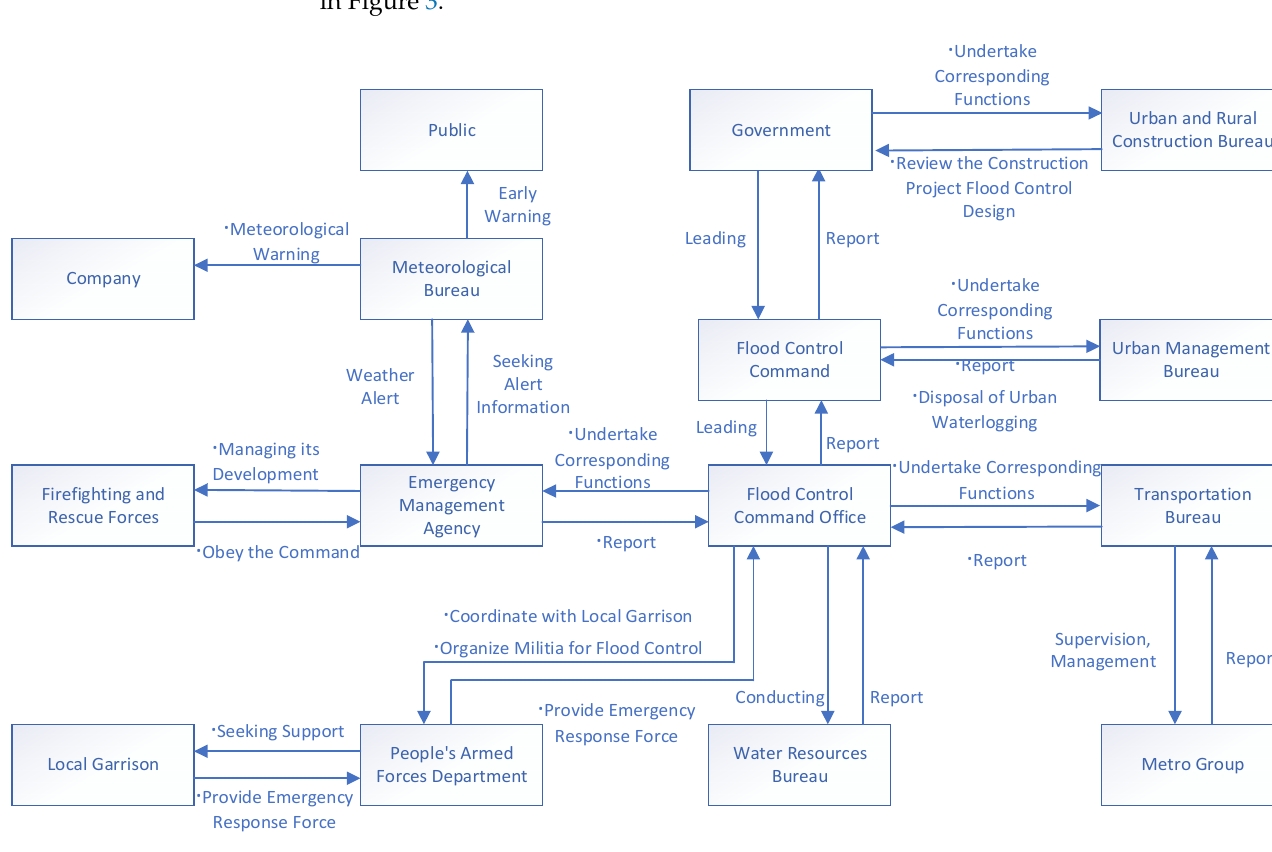
Figure 3. The Zhengzhou government’s emergency control structure.